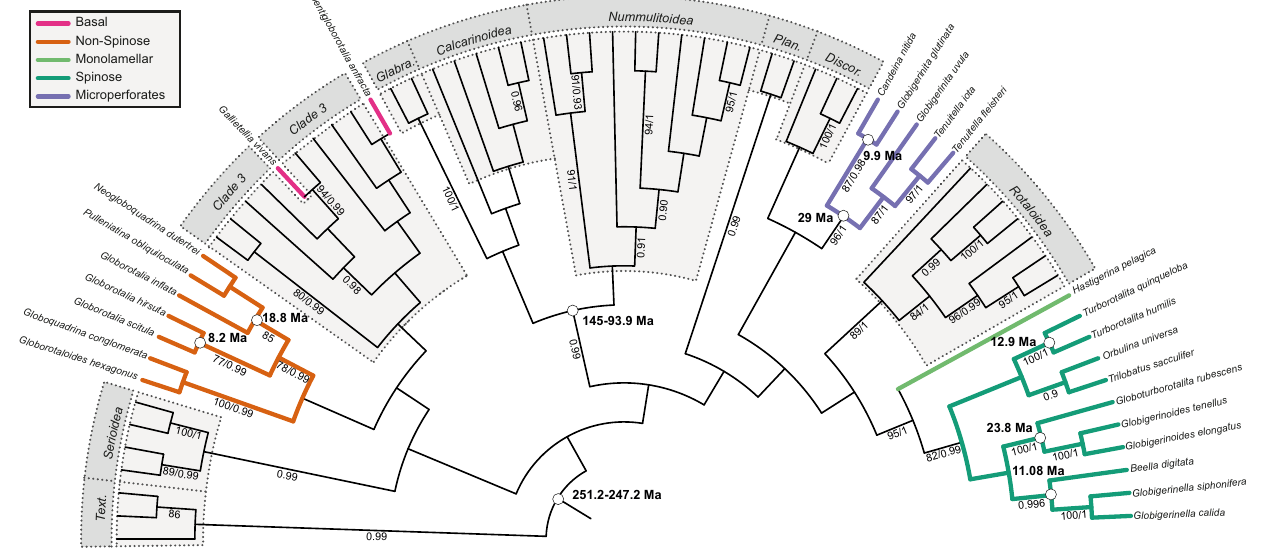
Fig. 4 | Phylogenetic relationship of extant benthic Globothalamea with planktonic clades. RAxML consensus topology showing the evolutionary rela- tionships between benthic Globothalamea clades (gray boxes) and the planktonic clades (colored lines). The tree is based on 44 benthic and 25 planktonic for- aminiferasequences. Bootstrap and posteriorprobability values above 80% or 0.9